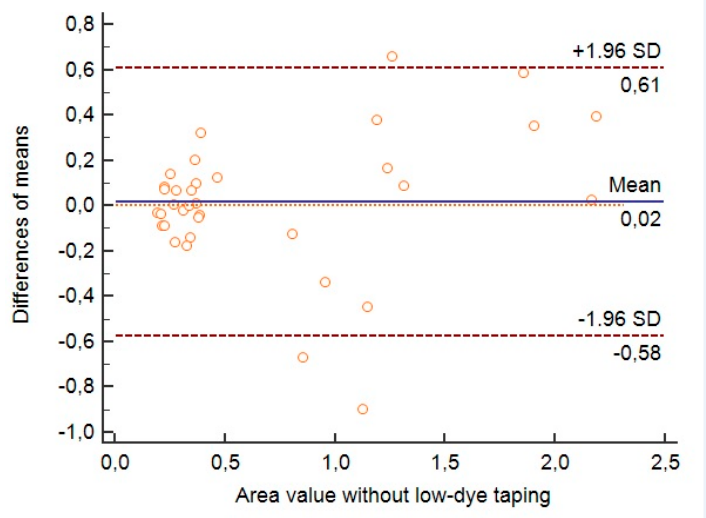
Figure 6. Bland–Altman graph comparing the results obtained for the variable Percentage of the Center of Pressure Locus Area without taping in the first session and in the second session of the participants. Abbreviations: Mean, media; SD, standard deviation. Table 5. Reliability of the percentage of the pressure center in the different times with the